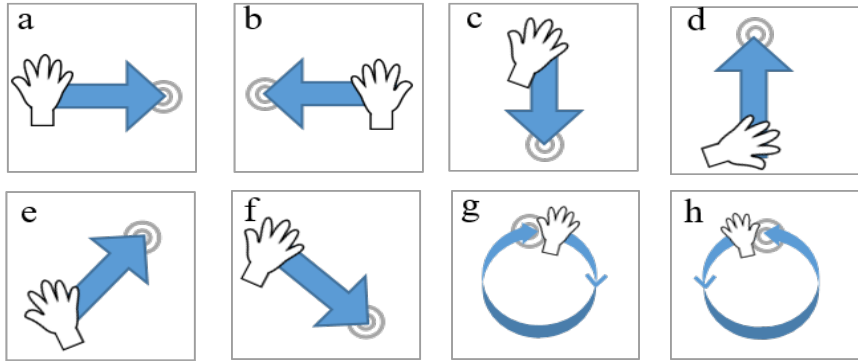
Figure 11. Gesture vocabulary: Eight gestures ( a – h ) used to evaluate the classifier.